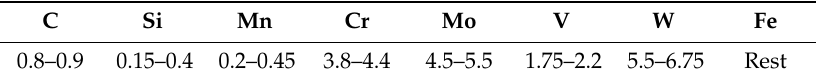
Table 1. Elemental composition (wt.%) of W6Mo5Cr4V2 high-speed steel powder.